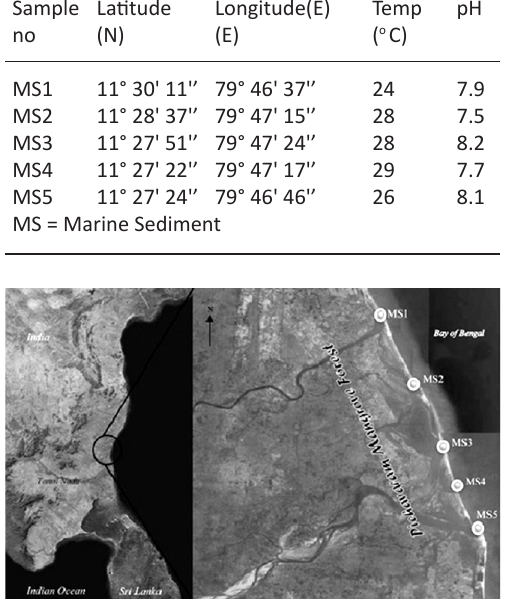
Fig. 2. Schematic representation map showing sampling area